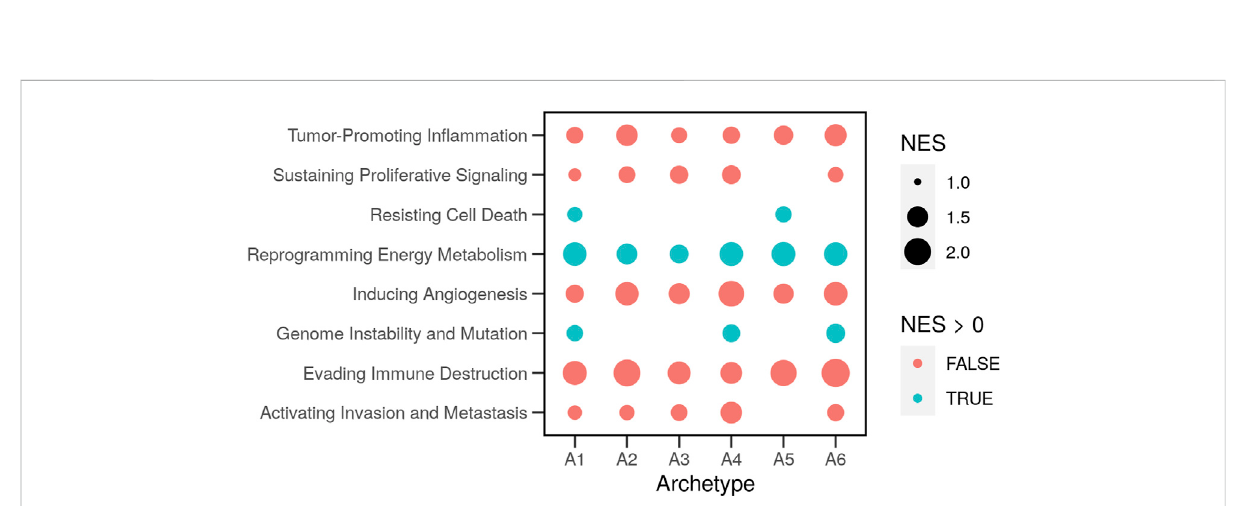
FIGURE 5 Enrichment of thehallmarkgene sets in thearchetypes of cancer cells. Genesknown to beinvolved inthe tencancer hallmarkswerecompiled in gene sets (Zhang et al., 2020). Gene expression pro fi les of cancer cell lines ( N = 46) with and without drug perturbations were obtained from the library of integrated network-based cellular signatures (LINCS). The characteristic direction (CD) of change between treated and control cells was determined. Genes were ranked based on the CD, and the overrepresentation of the hallmark gene sets (normalized enrichment scores; NES) was estimated in the top ( NES > 0) or the bottom ( NES < 0) of the ranked list.